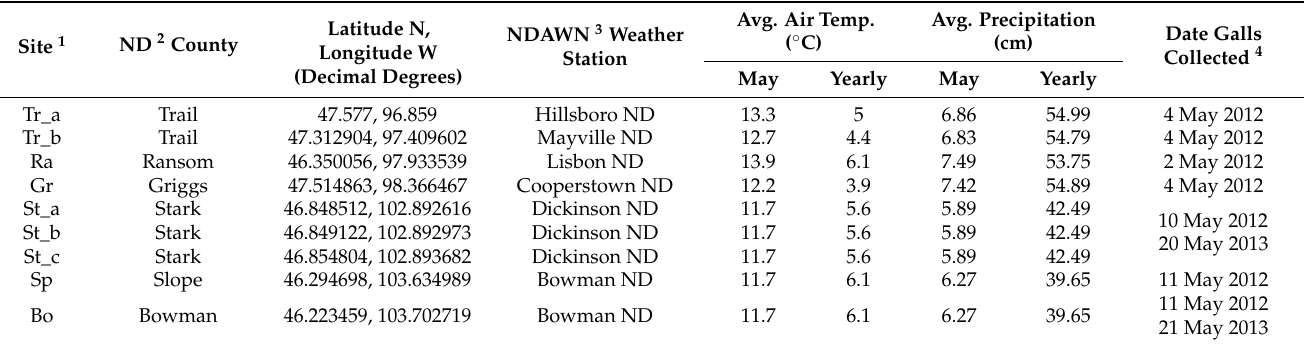
Table 1. Location and environmental characteristics of collection sites and sampling